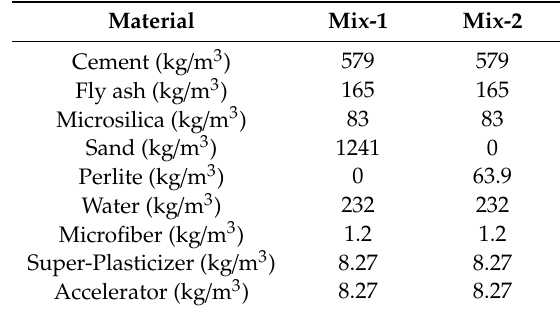
Table 3. Material proportions of 3DCP concrete mixtures.